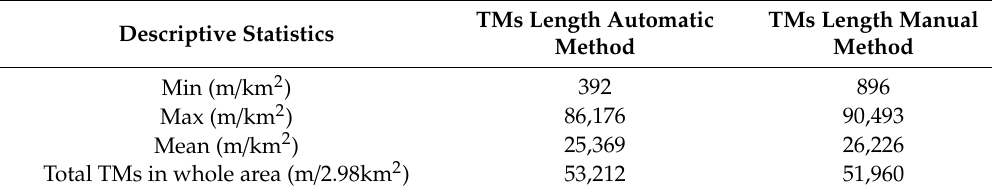
Table 1. Results of statistics on the quantification values of TMs length. The analysis calculates statistics for the blocks that contain TMs.